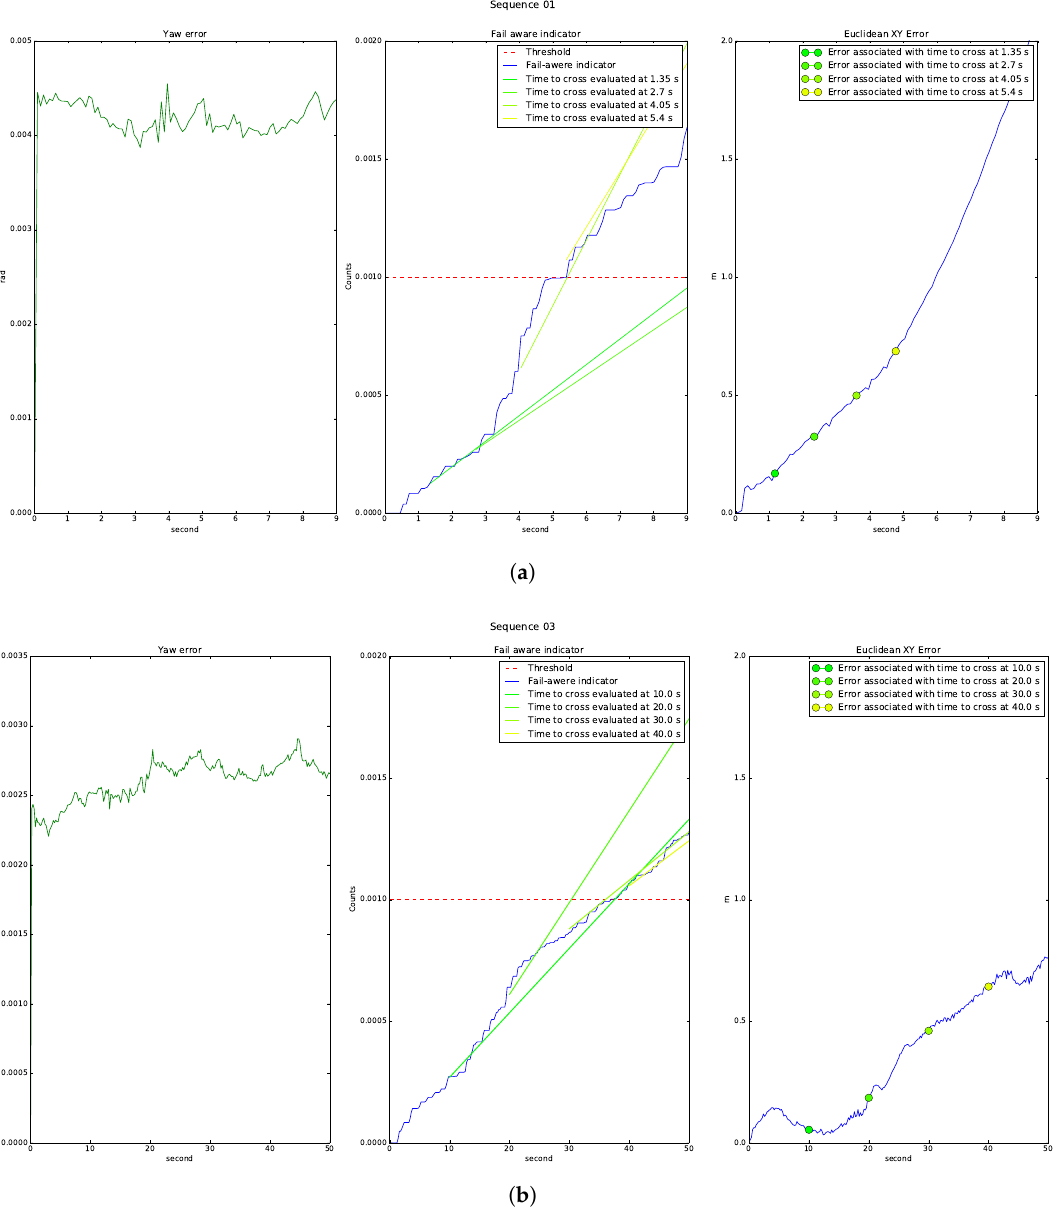
Figure 23. Dynamics of the fail-aware indicator: ( a ) Sequence 01 shows an estimated failure time of 5 s, which means that a high error is caused in a short time as a result of incorrect linear and angular localisation; ( b ) Sequence 03 shows an estimated failure time of 40